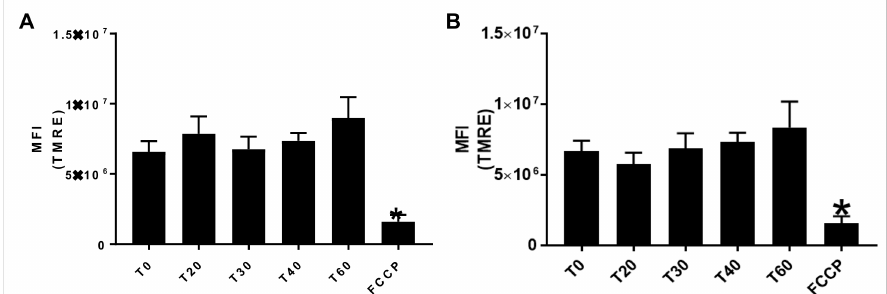
Figure 5. The e ff ect of elesclomol and CuCl 2 , as single agents, on mitochondrial membrane potential in whole cells. Fluorescence intensity measurements of ( A ) elesclomol and ( B ) CuCl 2 treated